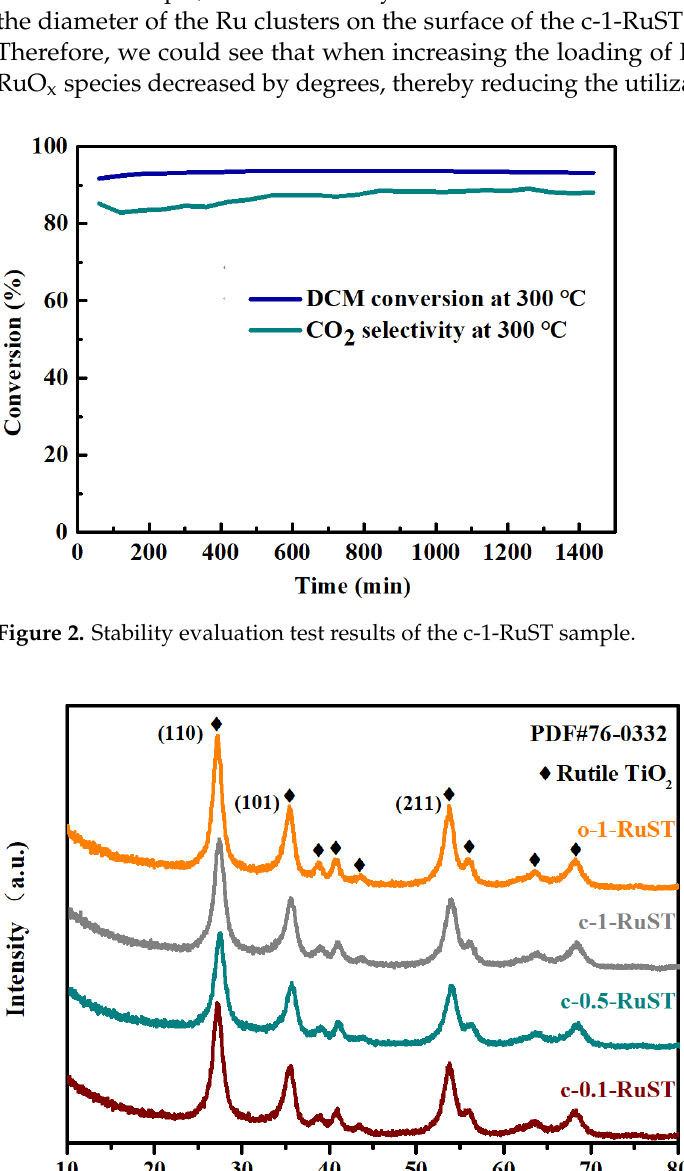
Figure 1. DCM catalytic oxidation performance test results for each sample: ( a ) DCM conversion